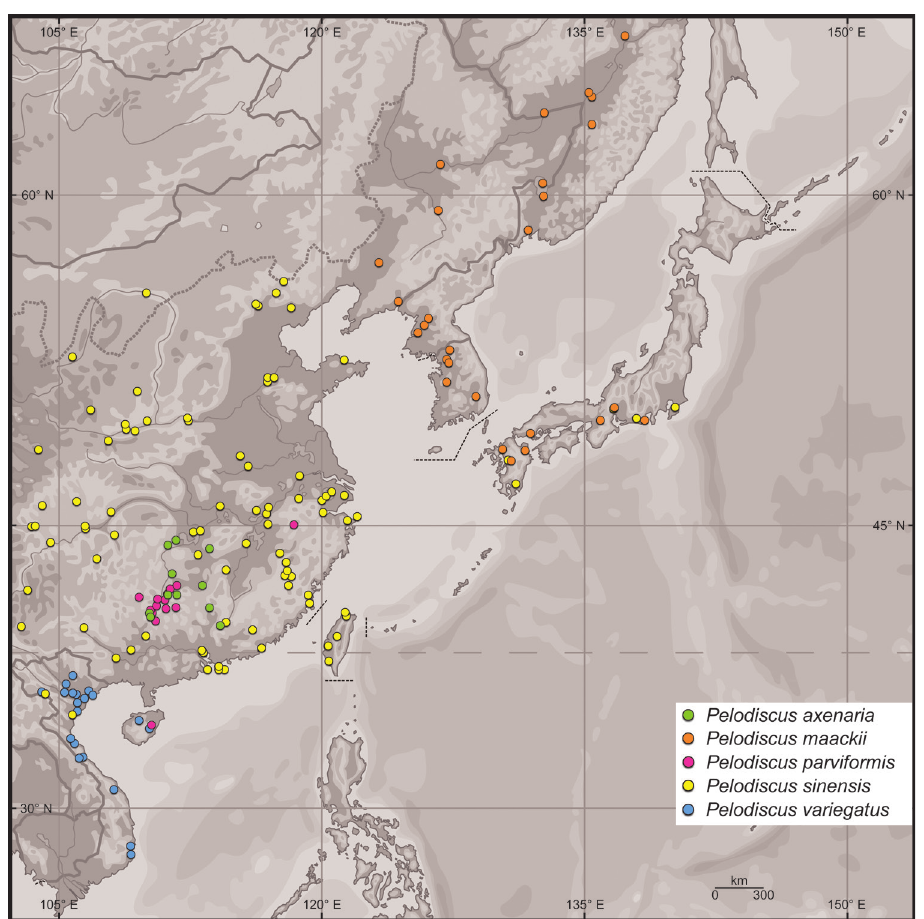
Figure 6. Currently known presence points of Pelodiscus species based on our own data as well as distri- bution maps published by the TTWG (2017) and Gong et al. (2018). Earlier records of P. sinensis from Hainan Island are referable to P. parviformis or P. variegatus sp. n. (see